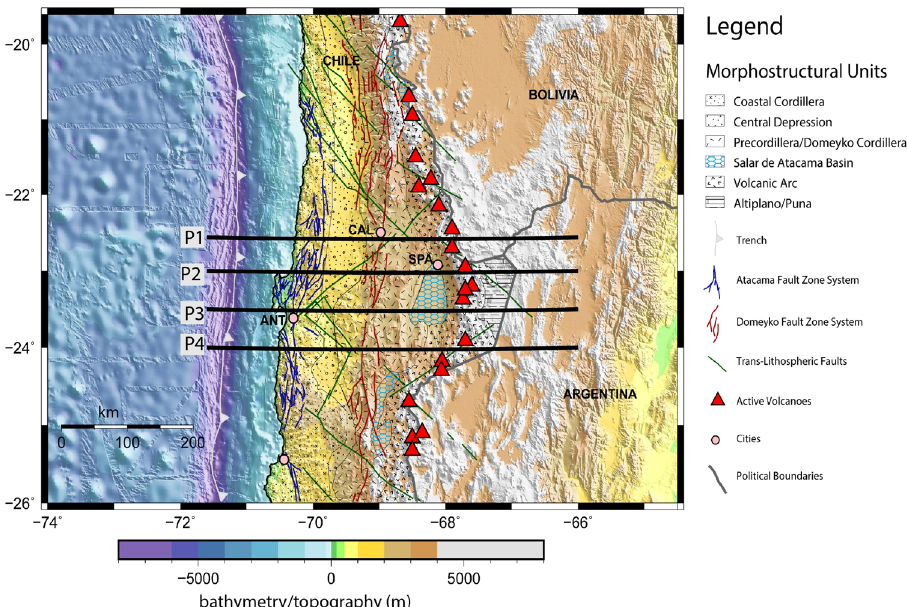
Figure 1. Bathymetric/topographic image of the northern Chilean subduction zone. The black lines denote the extracted profiles for the V p , V p / V s , and electrical resistivity cross sections shown in Fig. 2. Morpho-tectonic structures are based on the study of Santibañez et al. 38 . ANT: Antofagasta, CAL: Calama, and SPA: San Pedro de Atacama towns. The Atacama and Domeyko Fault Zone Systems (AFZS and DFZS, respectively) aligned approximately parallel to the trench axis. We use the GMT software version 5.0 (https:// www. gener ic- mappi ng- tools. org) for generating the